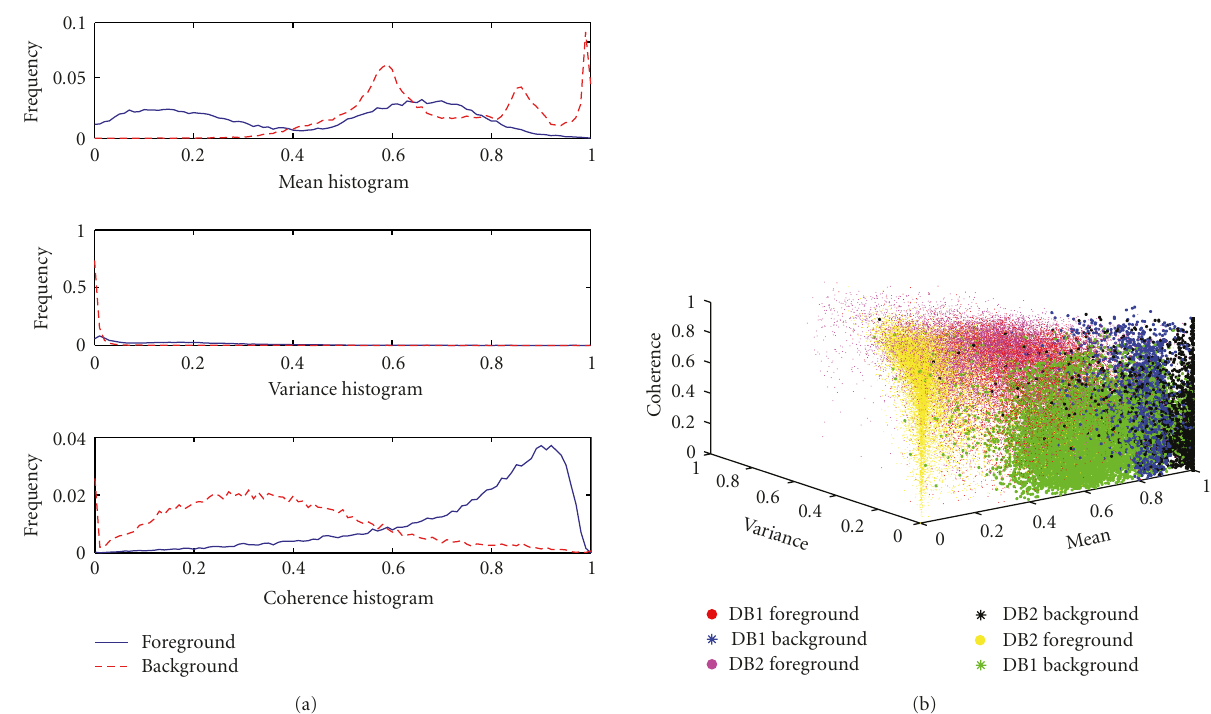
Figure 4: CMV histograms and distribution of the fingerprints in FVC2000 DB1, DB2, and DB3.